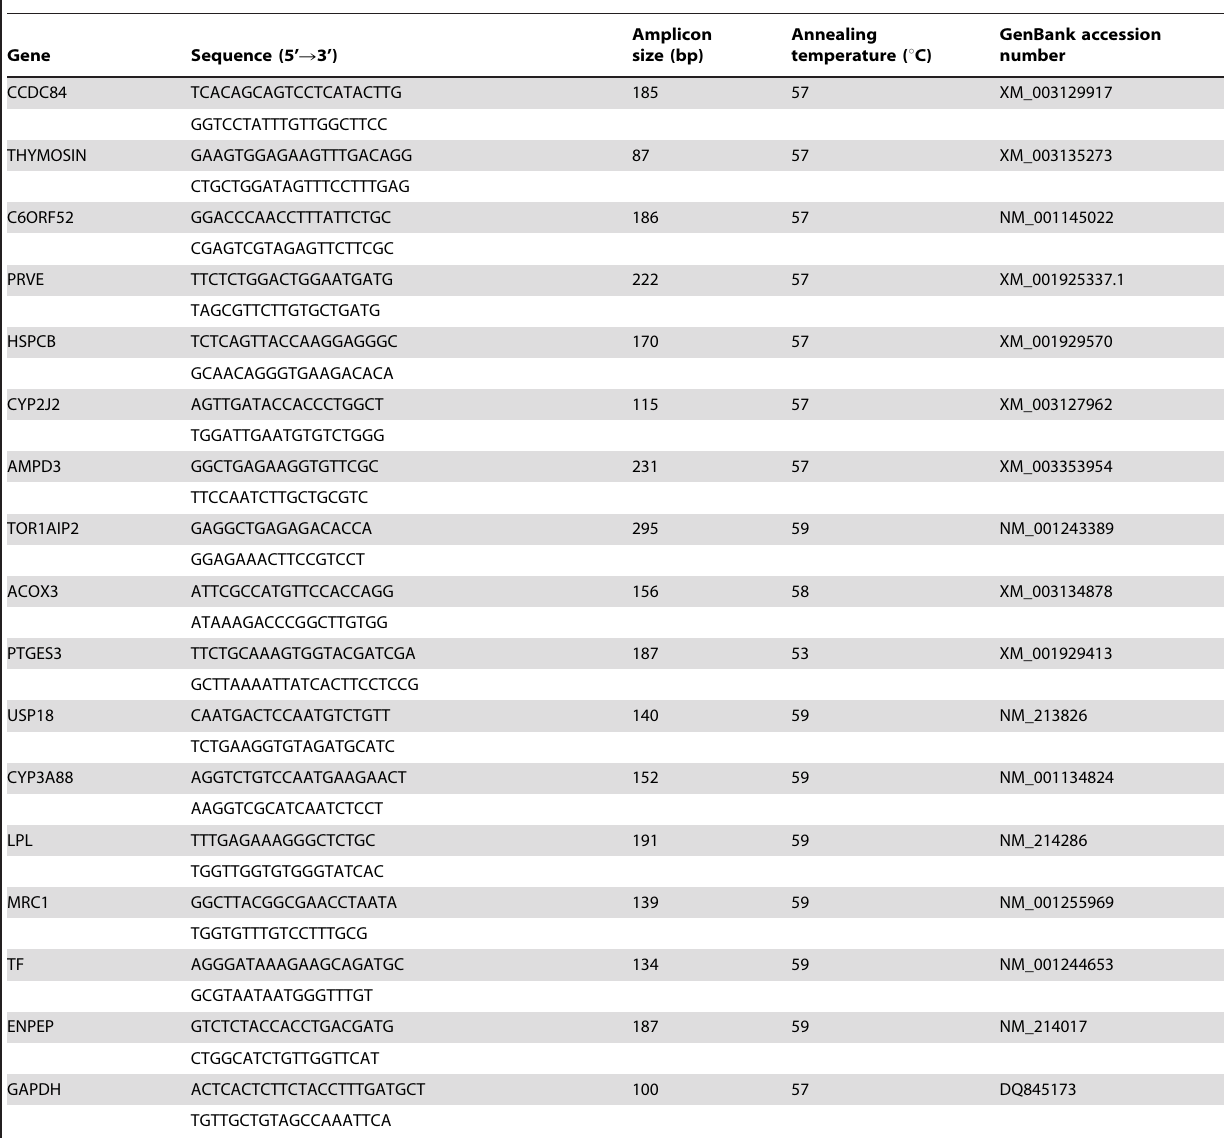
Table 1. Primers used for